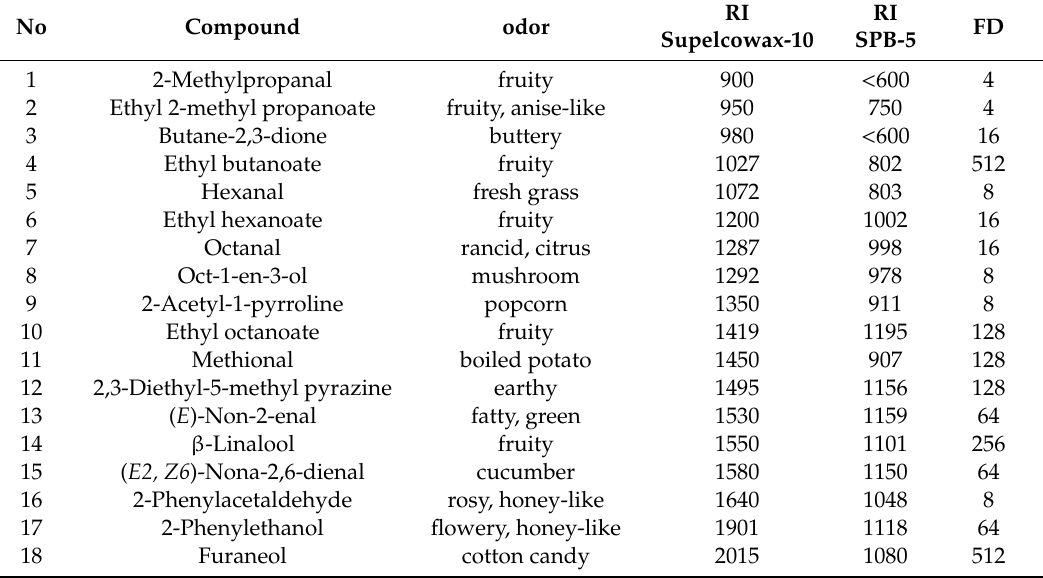
RI—Retention indices on a Supelcowax-10 and SPB-5 columns.